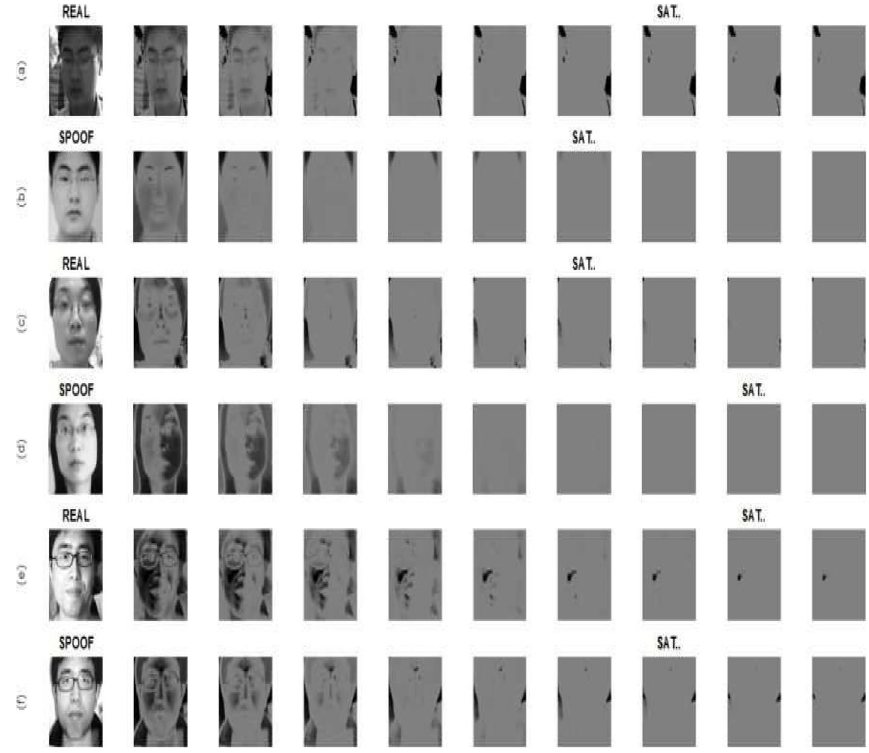
Fig. 5 Contrast reductionist life trails for real and spoof image samples using the logistic